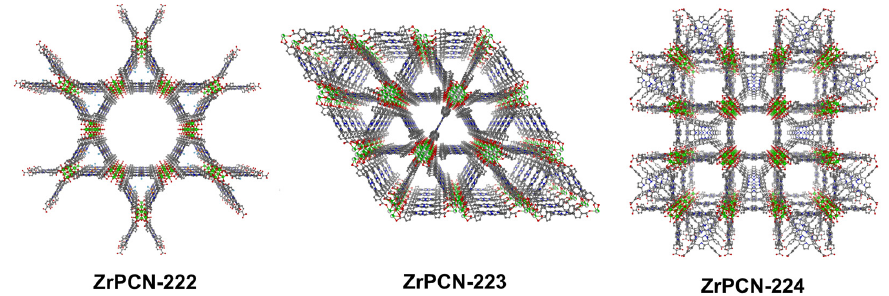
Figure 5. Porous coordination polymers (PCN) used as cancer theranostic agents.